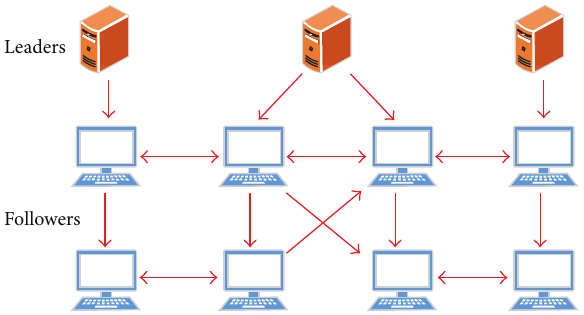
Figure 4: Containment control structure of leader-following multi- agent